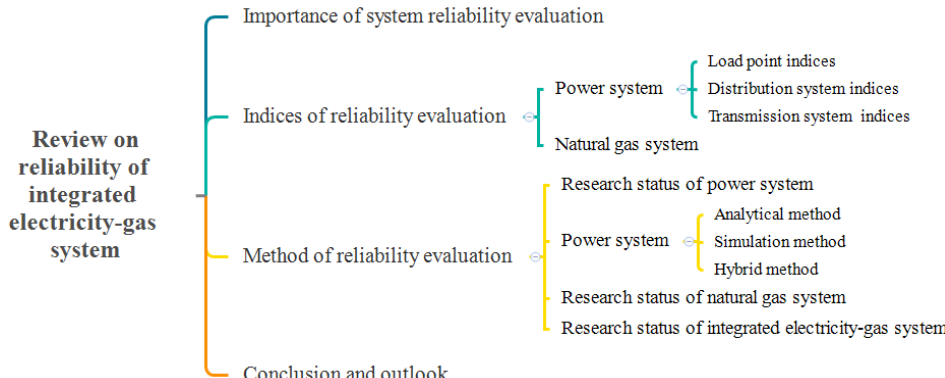
Figure 1. Outline of the paper.